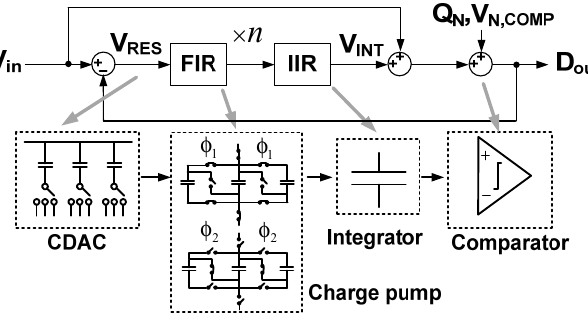
Figure 1. Functional representation of the proposed ADC.